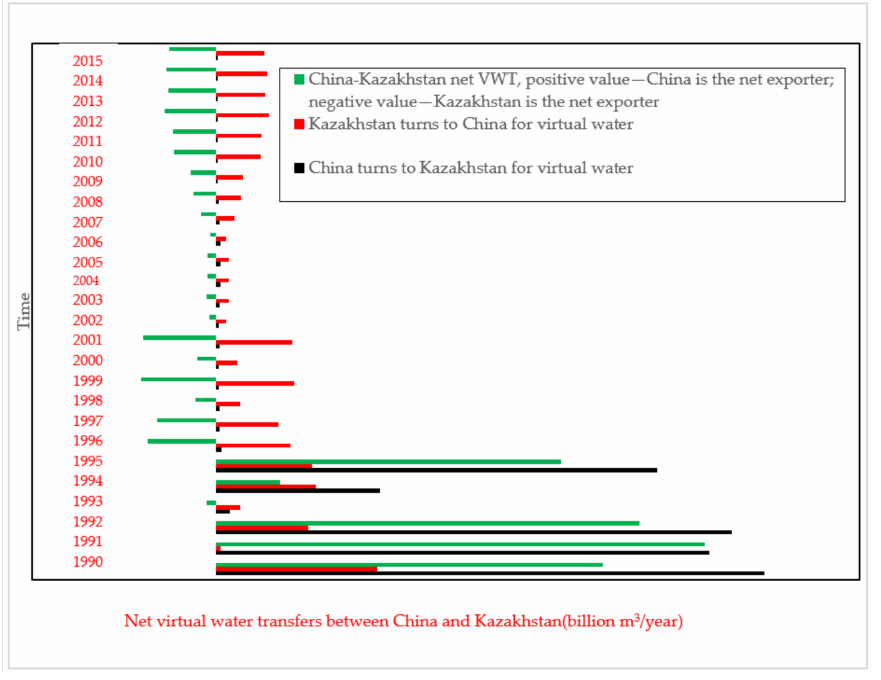
Figure 3. 1990–2015 Comparison of virtual water transfer between China and Kazakhstan.